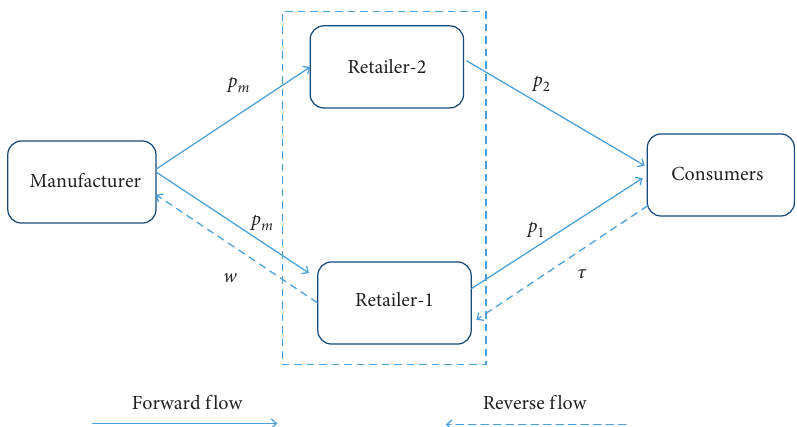
Figure 1: CLSC structure with two competing retailers without